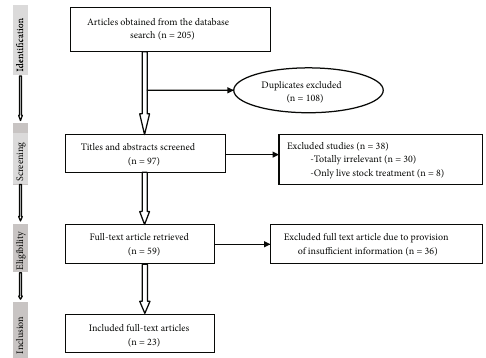
Figure 1: Flowchart of study selection for review of medicinal plants utilized for the treatment of gastrointestinal parasitosis in Ethiopia.